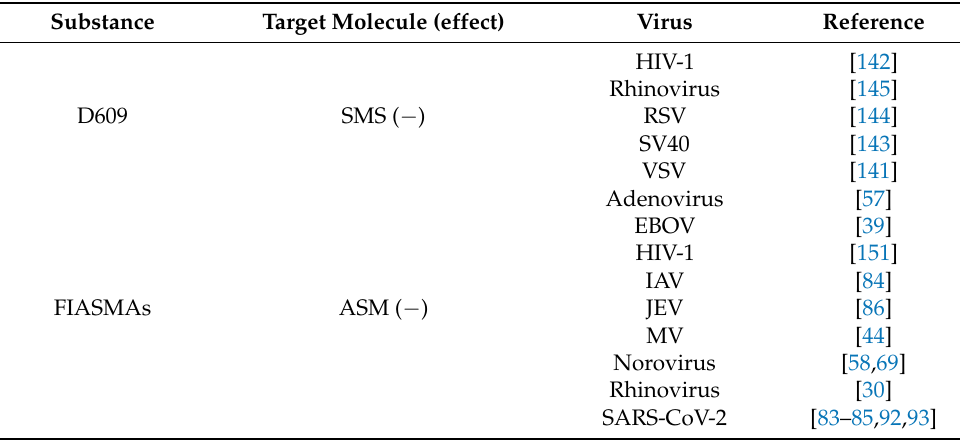
Table 2. Antiviral effects of ceramide-metabolism